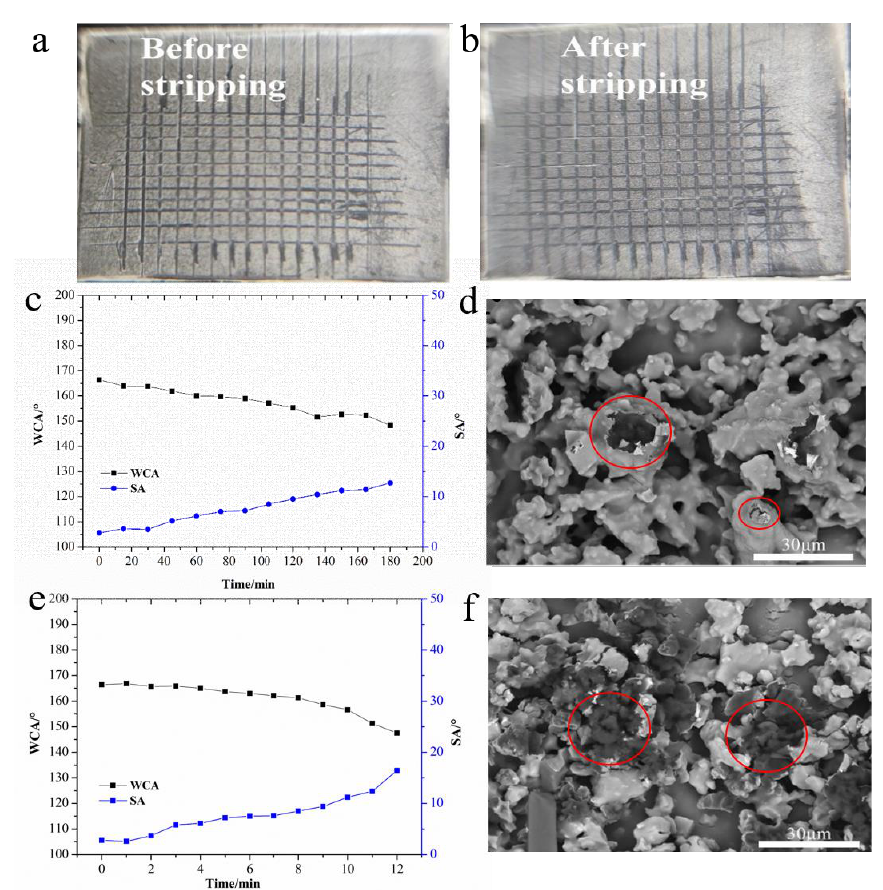
Figure 3. ( a ) Image before stripping; ( b ) image after stripping; ( c ) the change of WCA and SA during 3 h water droplet impact test; ( d ) SEM image of the coating after water droplets impact test; ( e ) the change of WCA and SA during 12 min sand impact test; ( f ) SEM image of the coating after sand impact test. In ( c , e ), WCA is the abbreviation of Water Contact Angle and SA is the abbreviation of Slip Angle, respectively.